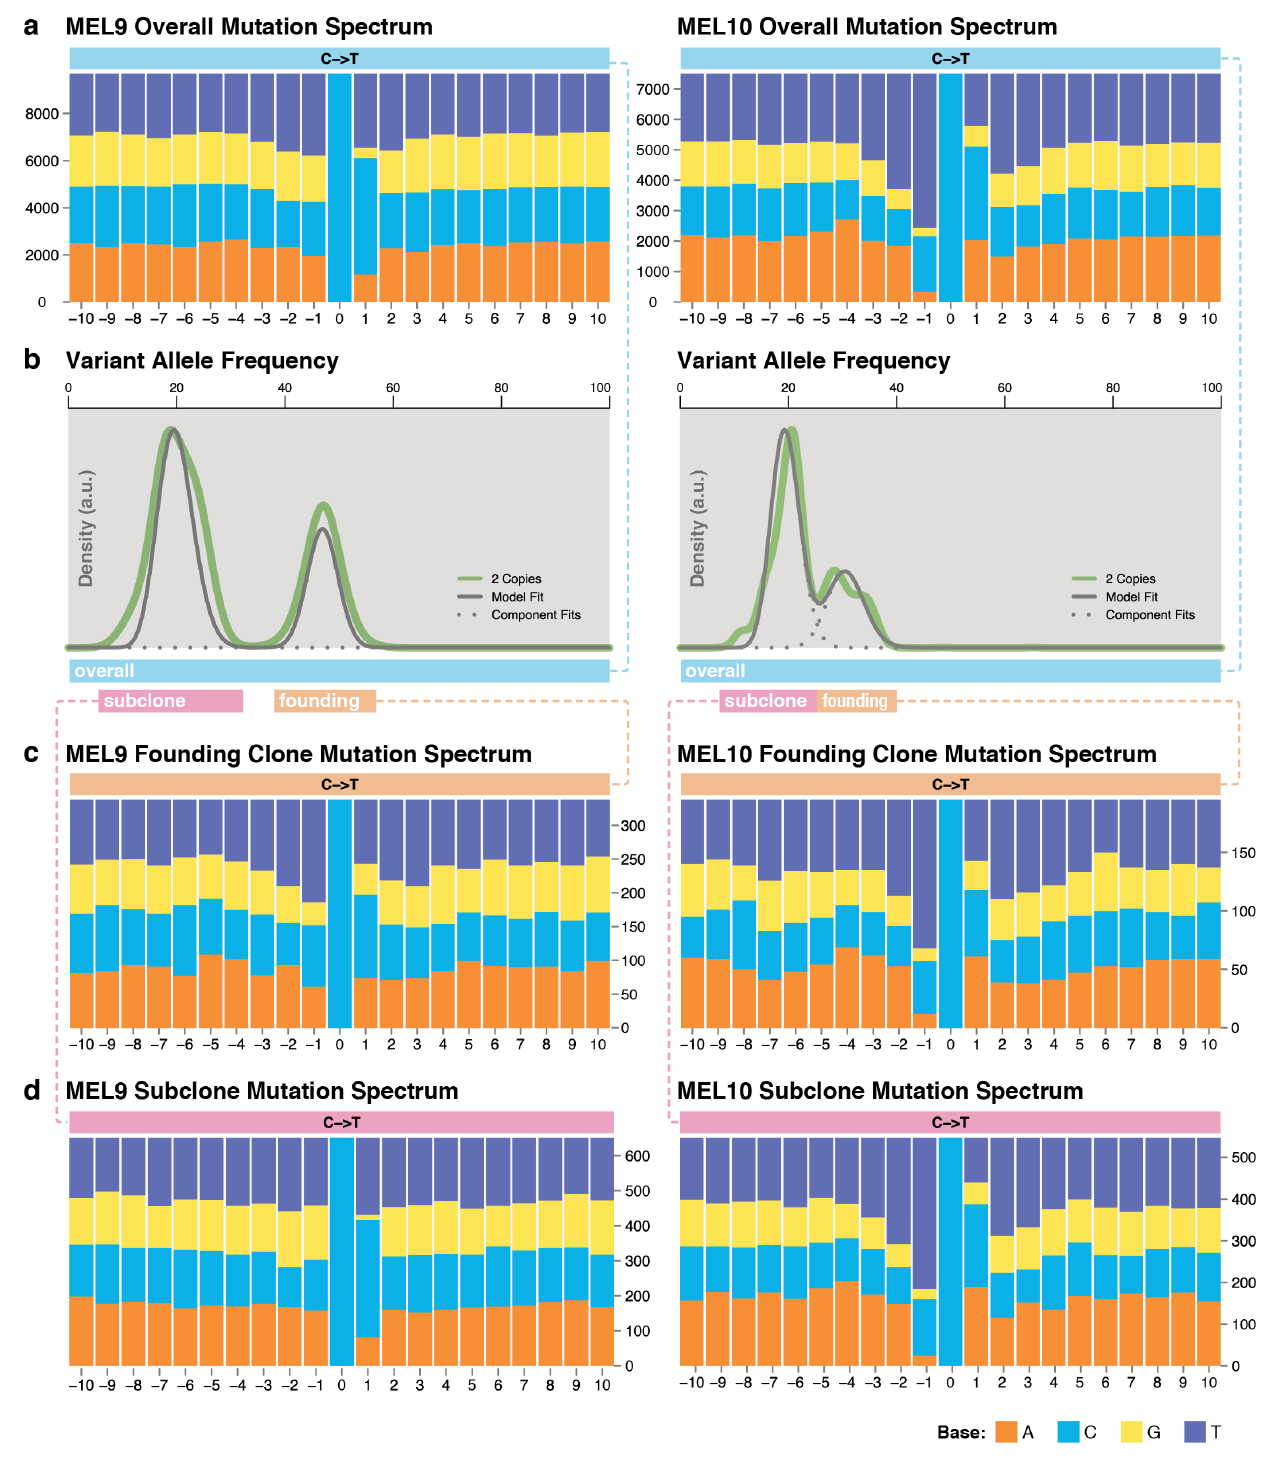
Figure 4. Dissecting mutational mechanisms using subclonal mutations. (a) Overall sequence context surrounding C- . T transitions in MEL9 and MEL10. (b) Density plots showing the founding clone and subclone in MEL9 and MEL10. (c) Mutation context analysis of the founding clones detected a UV mutation signature in both MEL9 and MEL10. (d) Mutation context analysis of secondary clones detected a UV signature in MEL10 but not MEL9.